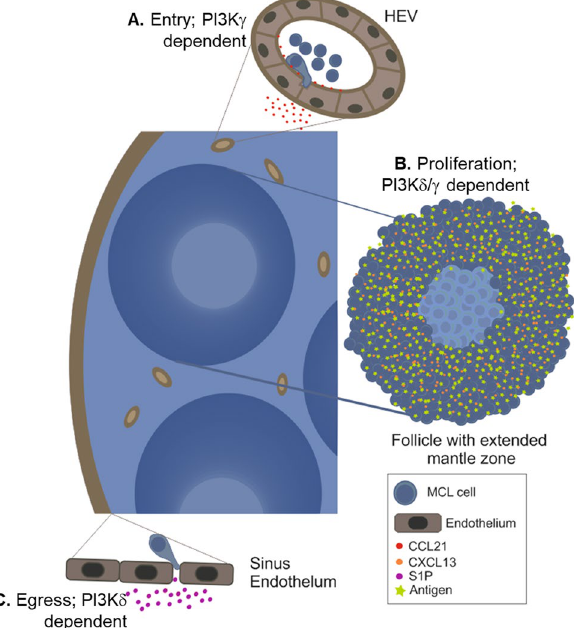
Figure 5. Schematic diagram of a MCL LN demonstrating the role that PI3K plays in the stages which determine lymphadenopathy. ( A ) Lymphocytes enter into the LN via the high endothelial venule (HEV) in response to CCL21 and move towards the follicle in a CXCL13-dependent manner; Chemokine-directed motility is dependent on PI3Kγ. ( B ) Once in the follicle they encounter antigen, undergo clonal expansion and are retained in the LN; proliferation is dependent on PI3Kδ/γ. ( C ) Exit (egress) is through the sinus endothelium is dependent on S1P. Expression of the egress receptor S1PR1 is inhibited by BCR signalling through PI3Kδ. Drawn using CoralDRAW 2017 (https:// www. corel. com/